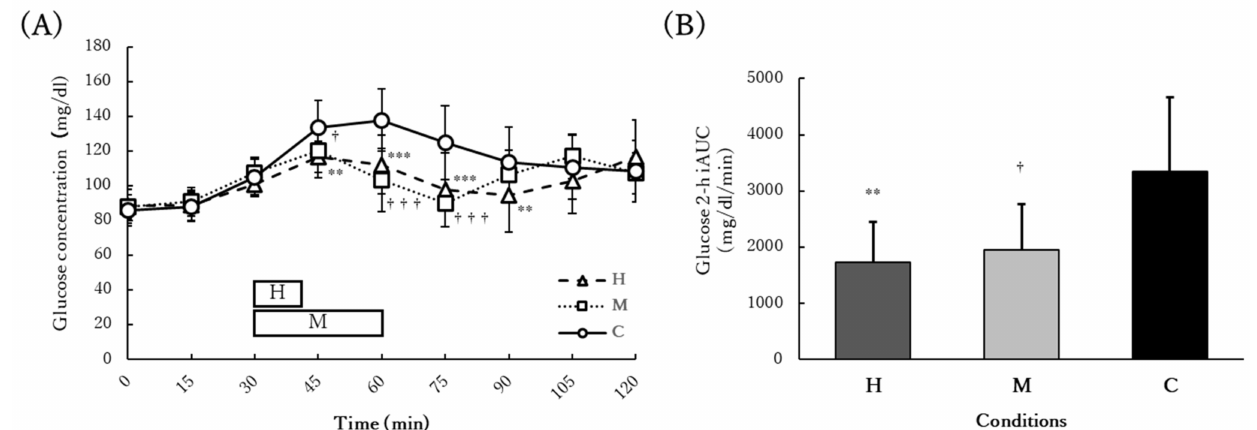
Figure 2. Changes in ( A ) glucose concentration up to 2 h after the standardized meal intake and ( B ) the iAUC. The participants performed 11 min of home-based HIIE 30 min after a meal in the H condition (H), 30 min of moderate-intensity exercise 30 min after a meal in the M condition (M), and 30 min of seated rest 30 min after a meal in the C condition (C). There were no significant differences between the H and M conditions. The H and M bars in panel ( A ) represent the timing of the exercises. ** p < 0.01 vs. C; *** p < 0.001 vs. C; † p < 0.05 vs. C; ††† p < 0.001 vs. C. Abbreviations: iAUC, incremental area under the postprandial glucose curve.